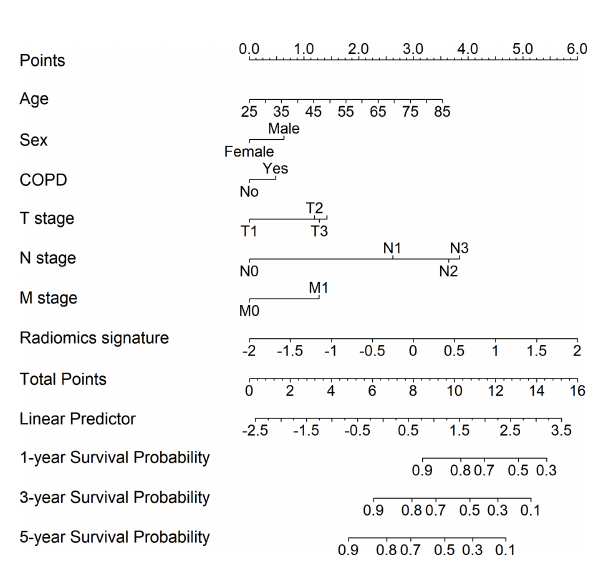
FIGURE 2 | Development of the radiomics nomogram for patients with non- small cell lung cancer by integrating the radiomics signature with clinical information to predict the probability of overall survival at 1, 3, and 5